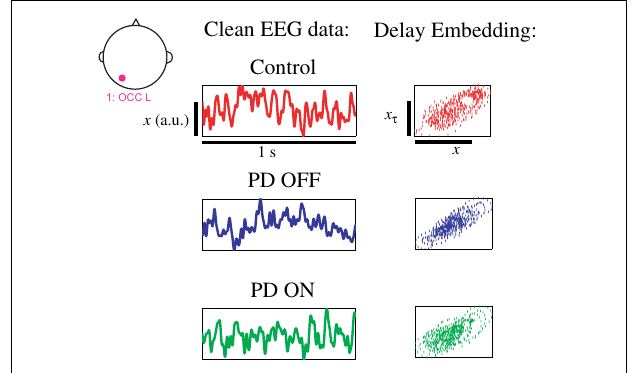
FIGURE 2 | EEG data from left occipital cluster of three exemplary participants with phase portrait reconstructed from left occipital cluster, using a delay τ of 8ms .